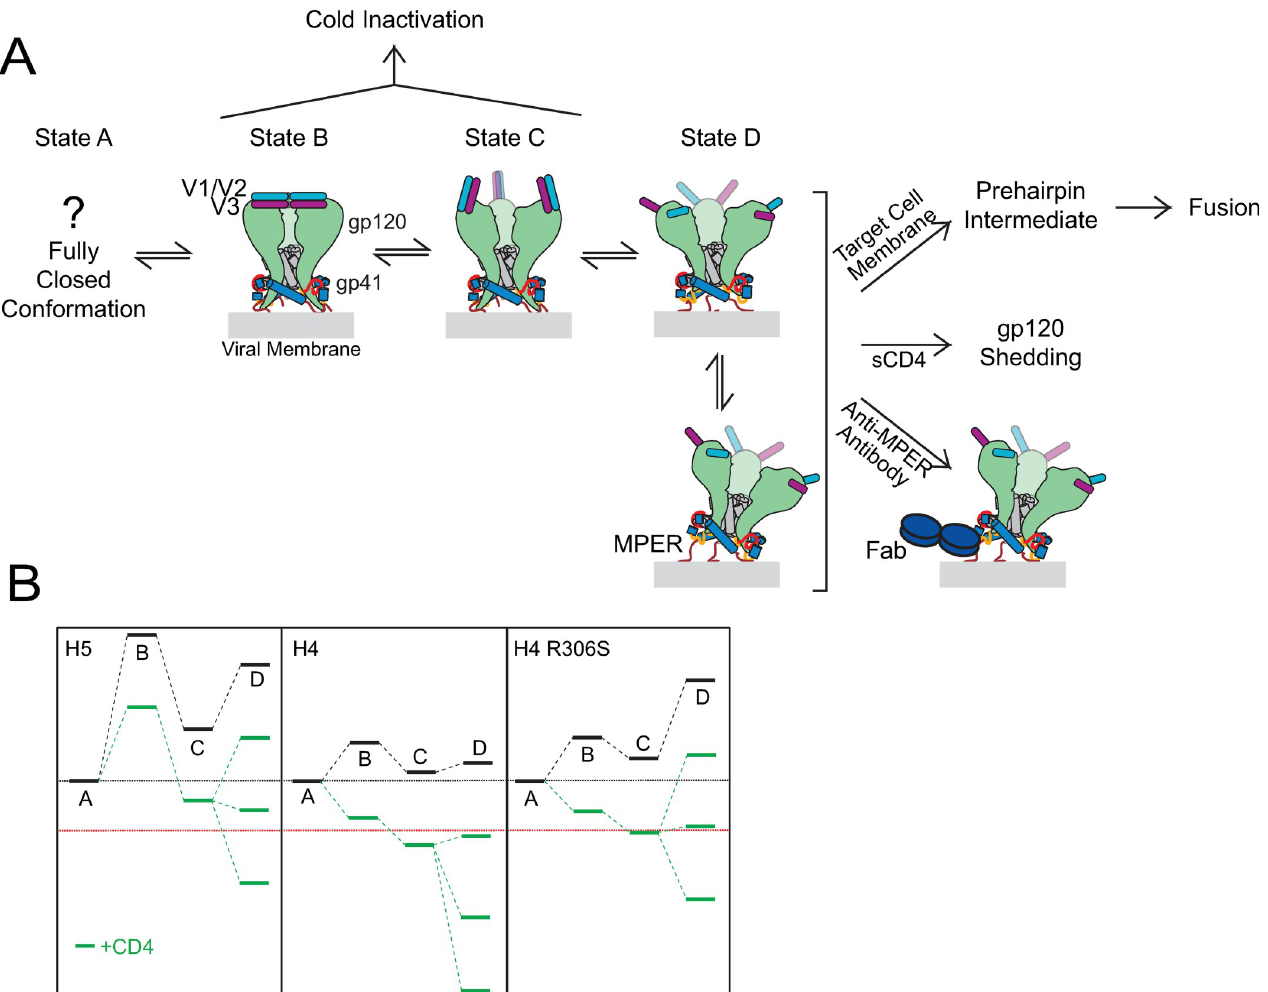
Fig 9. The V3-loop swap and R306S mutation have differential effects on the conformational equilibrium of Env HXB2 . ( A ) Model of HIV-1 Env conformational fluctuations in the prefusogenic state. The gp120 trimer (green) adopts a closed conformation in which the apical regions mediate interprotomer interactions (States A and B). Many neutralizing epitopes, including the gp41 MPER at the trimer base, are occluded in these states. Relaxation of the gp120 subunits leads to loss of apical interprotomer interactions, causing the V1/V2 (light blue) and V3 (magenta) loops to flip up in tandem, exposing numerous underlying epitopes, including the gp120 bridging sheet (state C). Finally, the V1/V2 and V3 loops splay, increasing trimer flexibility and enhancing its propensity to tilt relative to the membrane, thereby sufficiently exposing the gp41 MPER for antibody binding (Fab shown in dark blue) [82]. Note that only a single Fab binding is shown, even though there could be up to three antibodies bound per trimer. When sufficiently stabilized by CD4 binding, the fully-open State D conformation can be triggered by CoR interactions to complete conformational transitions that promote membrane fusion. Sensitivity to cold inactivation appears to reflect the ability of Env to spontaneously fluctuate into states B and C, while the CD4-dependence to gp120 shedding appears to correlate with the stability of state D. (B) Proposed impact of the V3-loop swap and R306S mutation on prefusogenic state energy levels in Env HXB2 . Black lines reflect unbound conformations, while green lines reflect CD4-bound states (for clarity, binding stabilization by more than one CD4 is shown only for state D). The red dotted line indicates the stabilization required to shift conformational equilibrium sufficiently into State D for efficient CoR-triggering of downstream structural transitions. The V3-loop swap that produced H5 Env primarily stabilizes state A relative to states B, C and D, shifting the equilibrium away from the more epitope-accessible conformations. Consequently, overall sensitivity to antibody neutralization, susceptibility to cold inactivation, and vulnerability to sCD4-induced gp120 shedding are reduced. By contrast, the R306S substitution stabilizes states A, B and C (states with interacting V1/V2 and V3 loops) relative to state D. As a result, sensitivity to anti-gp120 MPER antibodies and to sCD4-induced shedding is reduced, while sensitivity to anti-gp120 antibodies and to cold inactivation is largely unaffected. Both alterations increase the CD4 binding stoichiometry required to achieve sufficient stabilization of state D for CoR-triggered membrane fusion, accounting for the increased sensitivity of H5 and H4 R306S Envs to CD4 antagonist